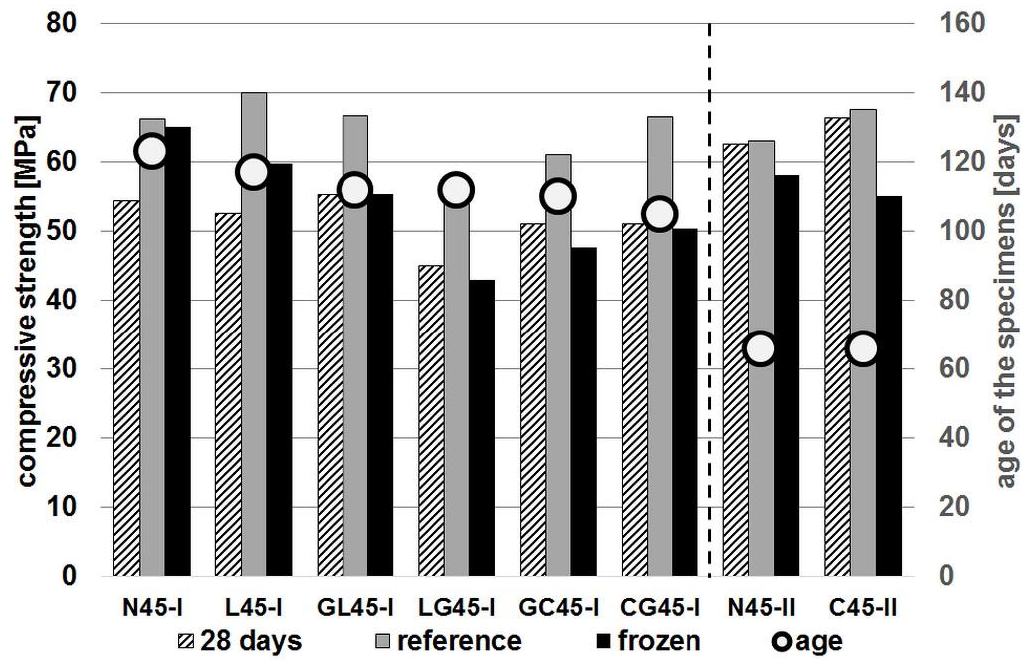
Figure 2. Results of frost resistance test (concrete series with w/c = 0.45).